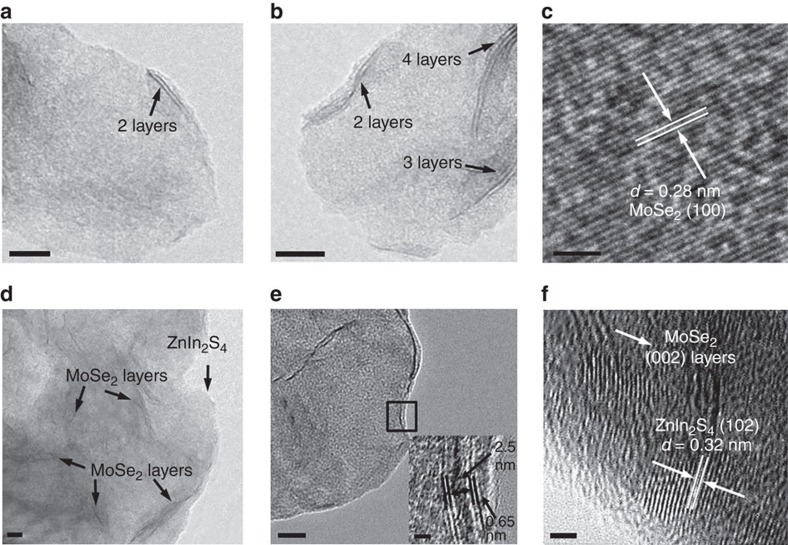
Morphology and structure of few-layered MoSe2 and hetero-layered ZnIn2S4/MoSe2.(a,b,d,e) Transmission electron microscopy (TEM) images of few-layered MoSe2 (a,b) and hetero-layered ZnIn2S4/MoSe2 (d,e). Scale bar, 10 nm. (c,f) High-resolution TEM (HRTEM) images of MoSe2 (c) and ZnIn2S4/MoSe2 (f). Scale bar, 2 nm. The inset in e is the magnification of the image shown in the black box of Fig. 2e. Scale bar, 2 nm.